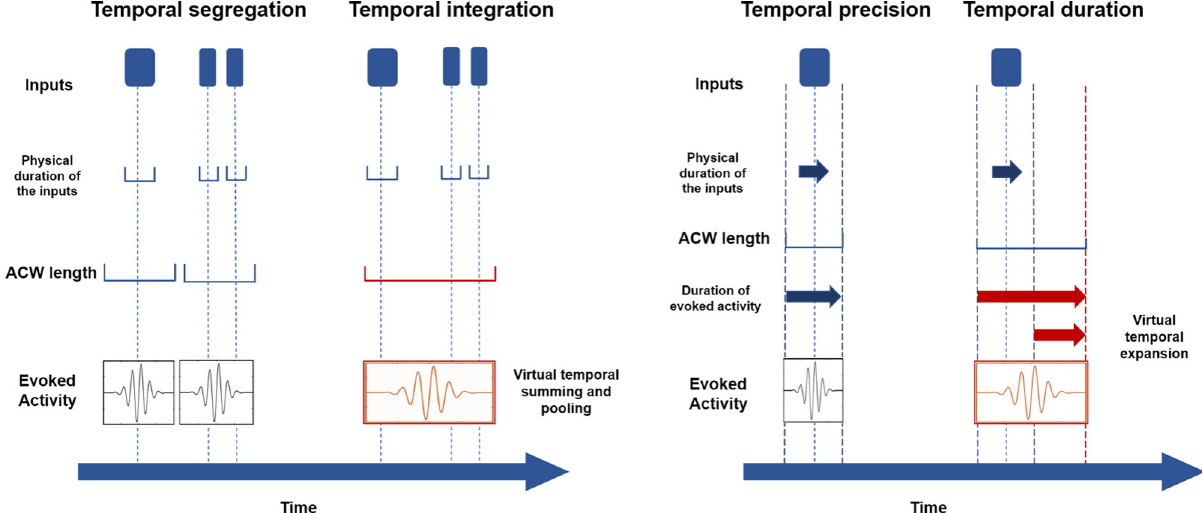
Fig. 5 Temporal integration vs. segregation and temporal precision vs. duration in task-evoked activity. The fi gure highlights two ways how the intrinsic neural timescales can manipulate input processing; this concerns the degree of integration vs. segregation of two (or three) different stimuli (left part) and the degree to which the temporal duration of the stimulus itself can be expanded in neural activity through longer time windows such that the duration of the neuronal activity related to the stimulus, i.e., neuronal duration, is extended beyond the stimulus ’ physical duration (right part). From left to right, the fi gure shows how shorter ACW (especially in unimodal regions) permits to distinguish fast stimuli (high degree of segregation) with a precise temporal encoding consistent with the physical duration of the stimuli (high temporal precision associated with short evoked activity). On the other hand, longer ACW (especially in transmodal regions) permits higher correlation of neural activity across time (high degree of integration), leading to the virtual expansion of the actual stimulus (high temporal duration associated with long evoked activity), i.e., the capacity to encode different stimuli in a way that the evoked activity is longer than the actual physical duration of